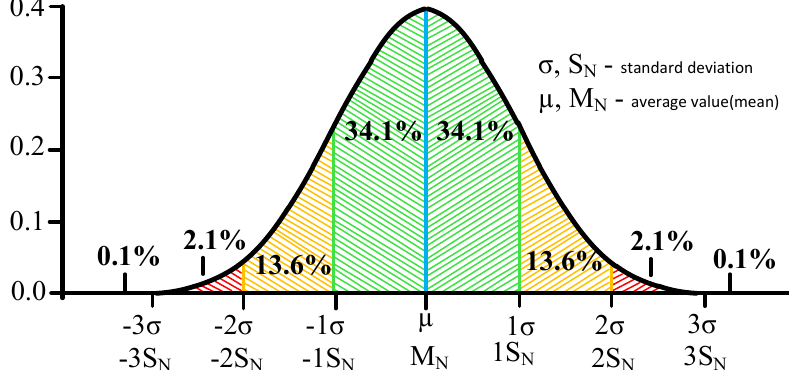
Figure 3. Graph of normal distribution probability density and percentage of random value hit on the sections equal to the standard deviation.